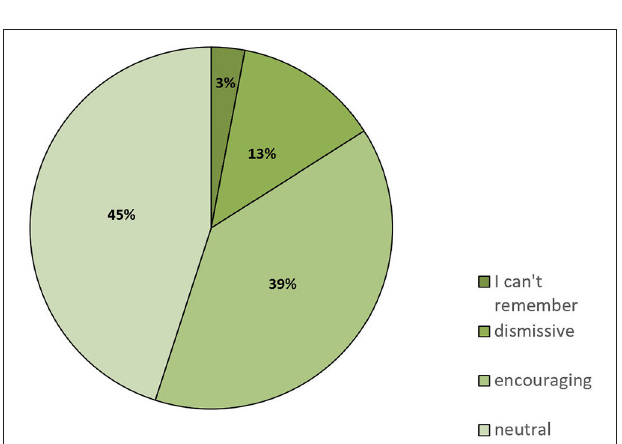
FIGURE 3 | Responses to the question of how family and friends reacted when informed that the patient had switched to a KD or similar LC diet ( n =